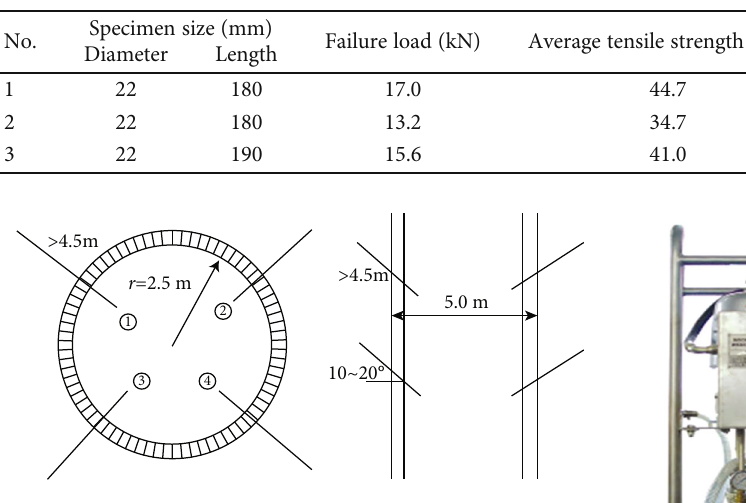
Table 10: Uniaxial tensile strength test.